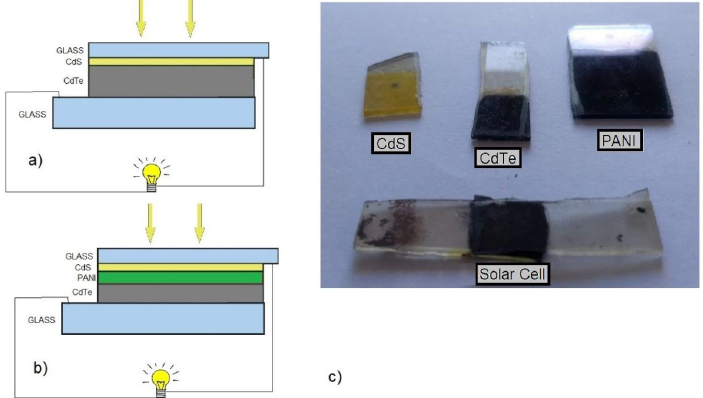
Figure 13. a) Assembly diagram of the cell without PANI, b) assembly diagram with PANI and c) the parts of the cell and its assembly. source: the author. The dashed line in blue represents the relationship between current density (mA/cm 2 ) versus voltage (V), the dotted line in red represents the power density curve (mW/cm 2 ) versus voltage (V), the chart in yellow represents the fill